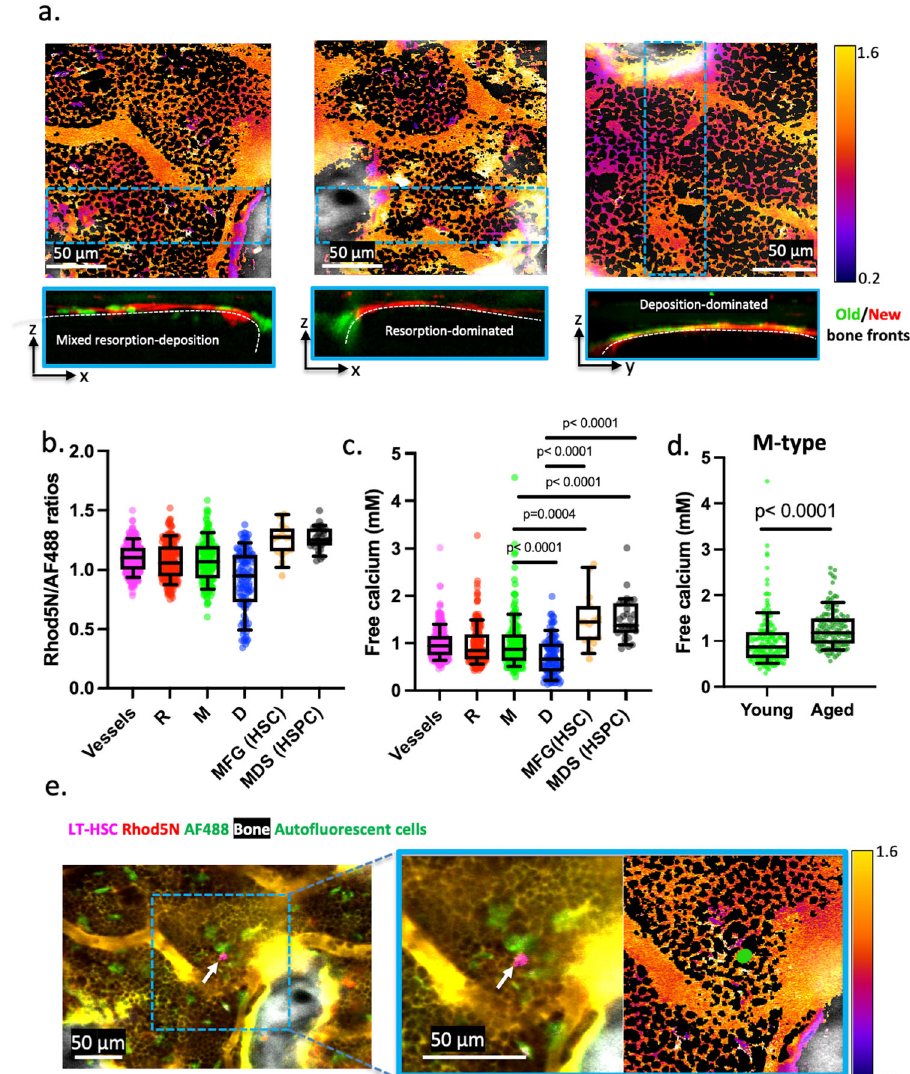
The correct version of Fig. 4